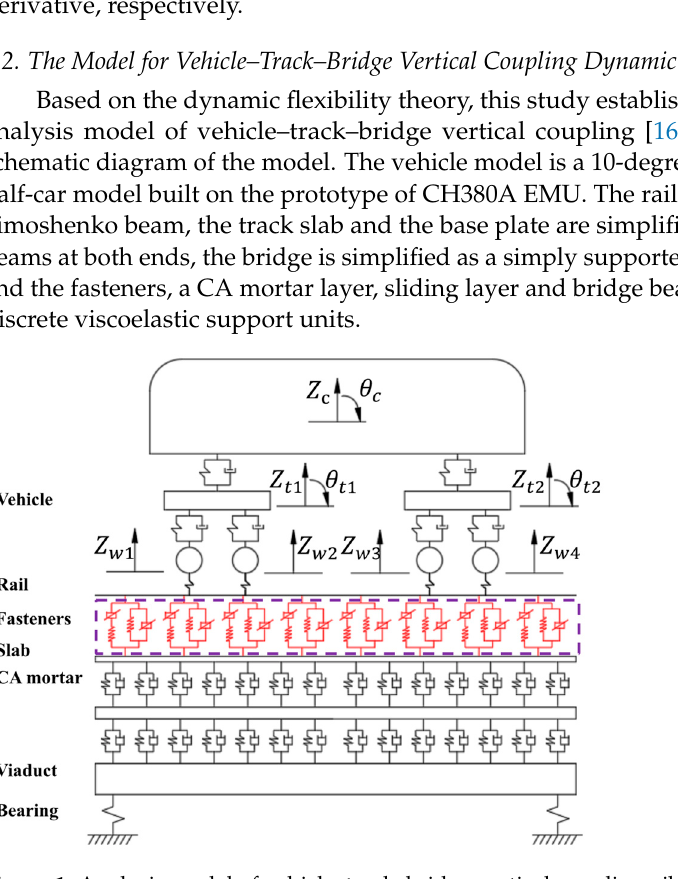
Figure 1. Analysis model of vehicle–track–bridge vertical coupling vibration.